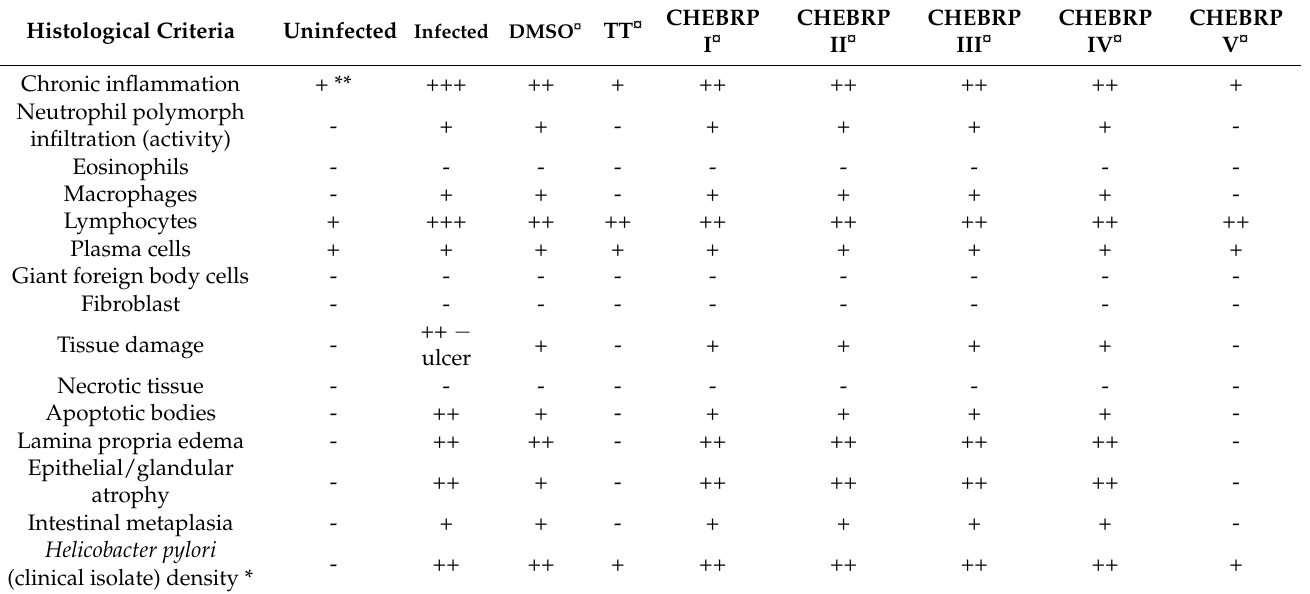
Table 4. Qualitative analyses of gastric tissues (antrum-pyloric) of the experimental groups during Helicobacter pylori (clinical isolate) infection in